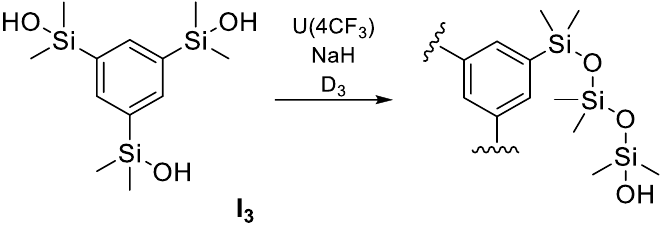
8 of 37 Figure 6. Proposed mechanism of ROP of D 4 (adapted with permission from Ref. [65]. 2007, Rodri- guez, M) However, other types of catalysts are also mentioned in the current literature. For example, Bashim Yactine used potassium vinyldimethylsilanolate (KVDMS) and potas- sium trimethylsilanolate (KTMS) catalysts in his work to perform ROP. Anionic polymer- ization of D3 initiated by potassium vinylsilanolate proved to be very efficient for the syn- thesis of difunctional and monofunctional polydimethylsiloxanes, respectively [66]. Oka et al. used the urea anion as a catalyst for ring-opening polymerization (ROP) of a cyclic siloxane initiated from silanols, which allowed control of the molecular weight